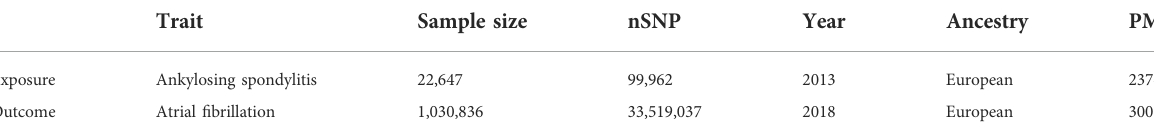
TABLE 1 Data sources of summary datasets.